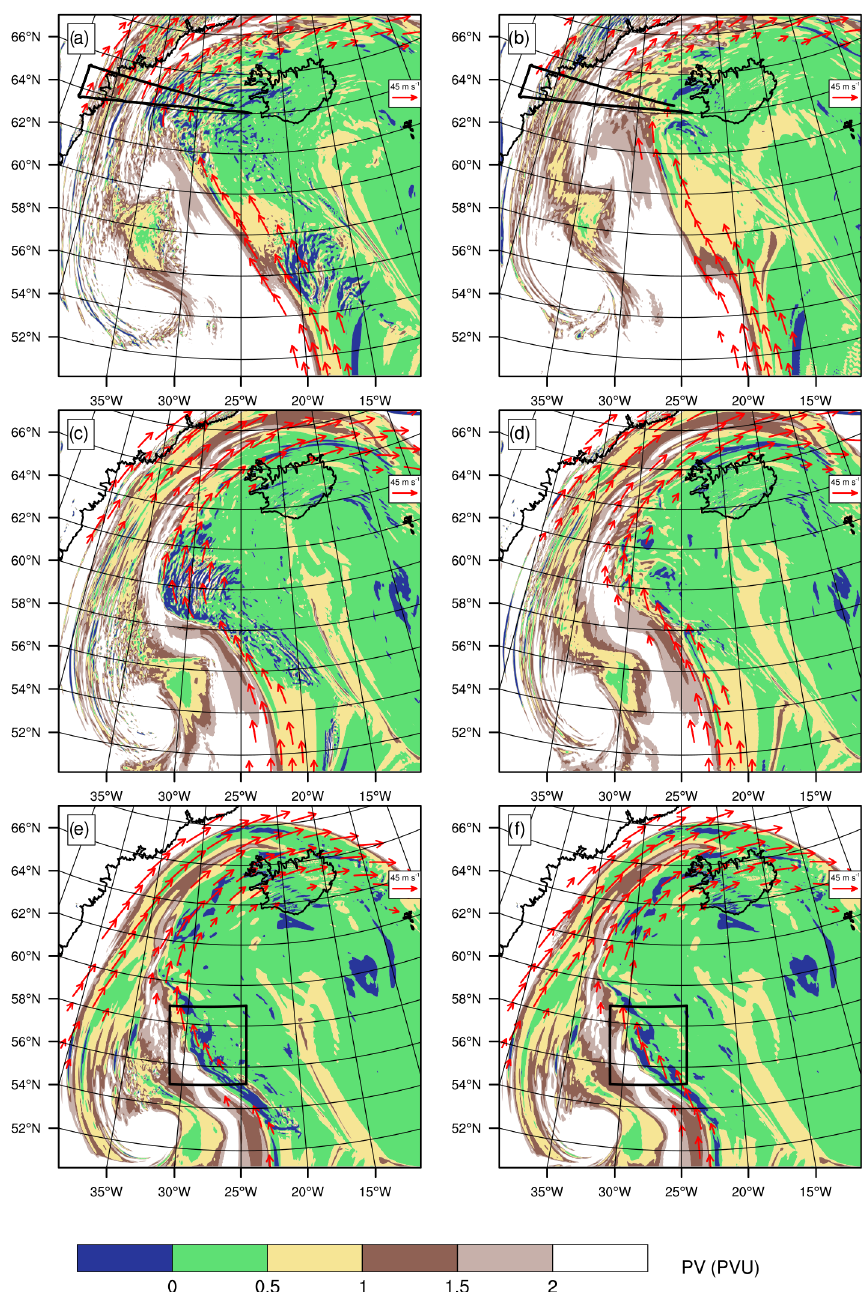
Figure 8. PV (shading) and wind above 45ms − 1 (red arrows) on the 320K level at (a, b) 11:00, (c, d) 06:00 and (e, f) 02:00UTC simulated by (a, c, e) REF and (b, d, f) NODIA. The black line (a, b) shows the track of the Falcon 20 aircraft, and the box (e, f) indicates the area that has been magnified for Figs. 9 and